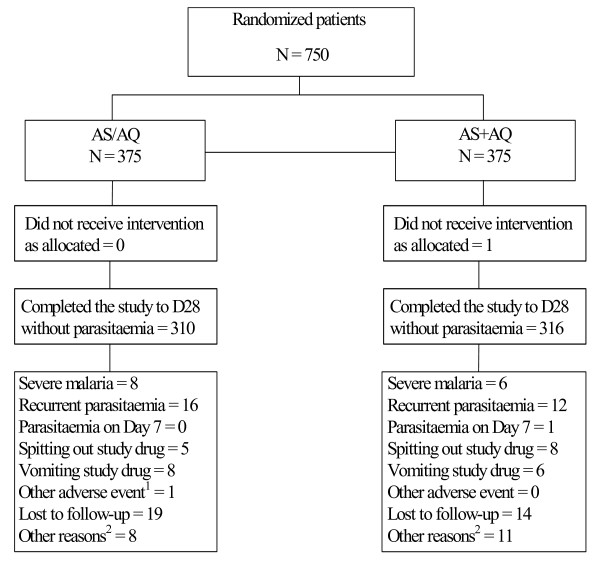
Patient disposition. 1. SAE: 8 month old girl hospitalized for gastroenteritis. 2. Other reasons were: parent's/guardian's decision; patients taking anti-malarial drugs during follow up.